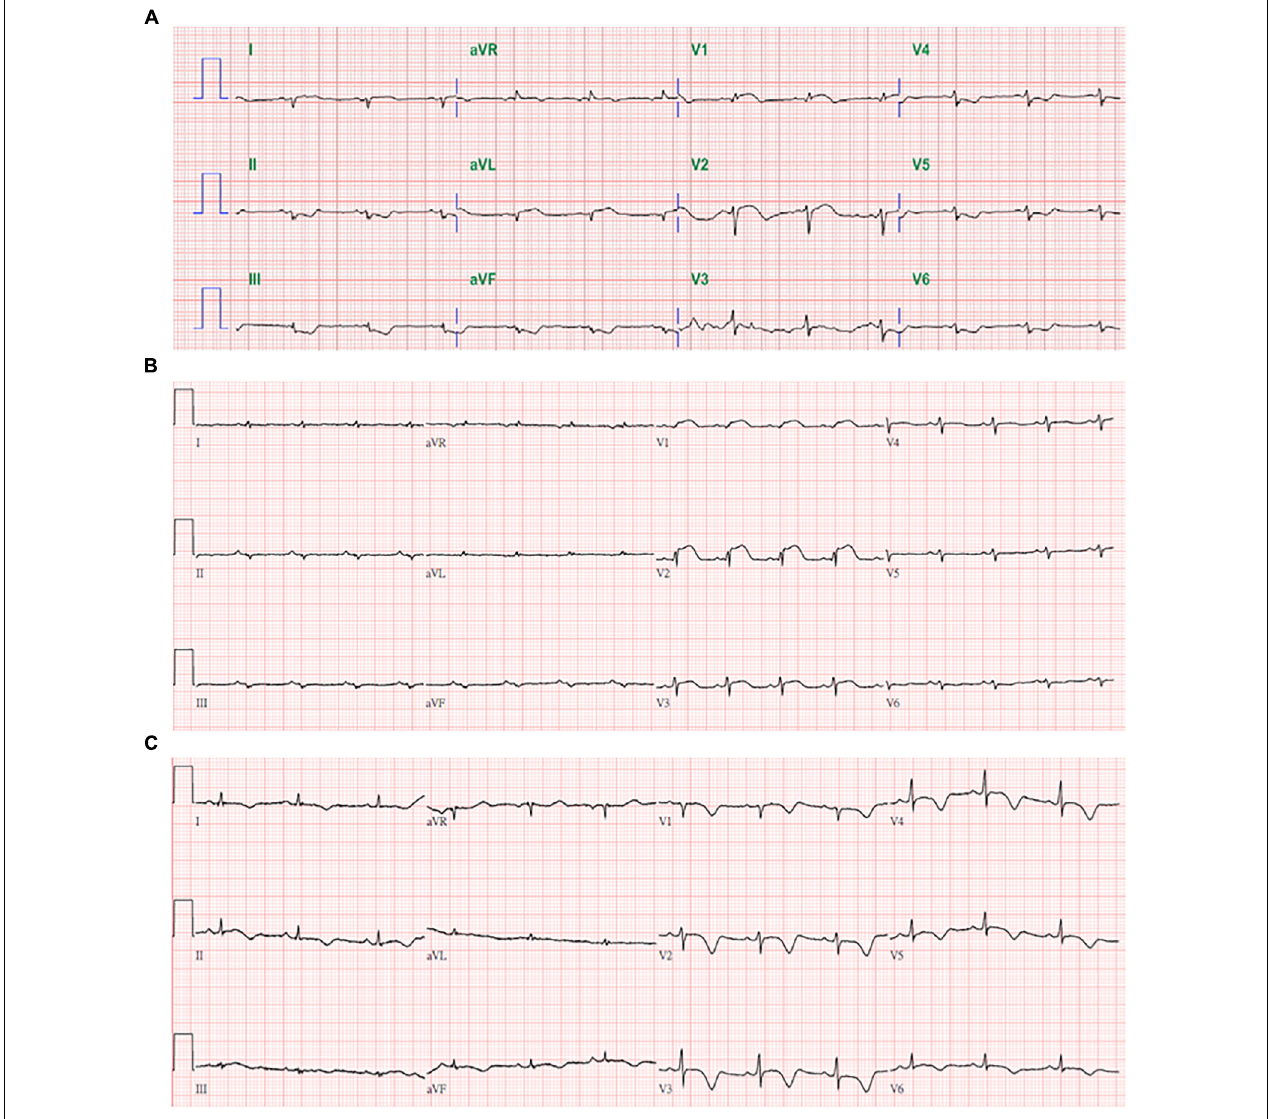
FIGURE 1 | Serial in-hospital ECGs on 8/11 (A) from other hospital, 8/13 (B) , and 8/24 (C) .